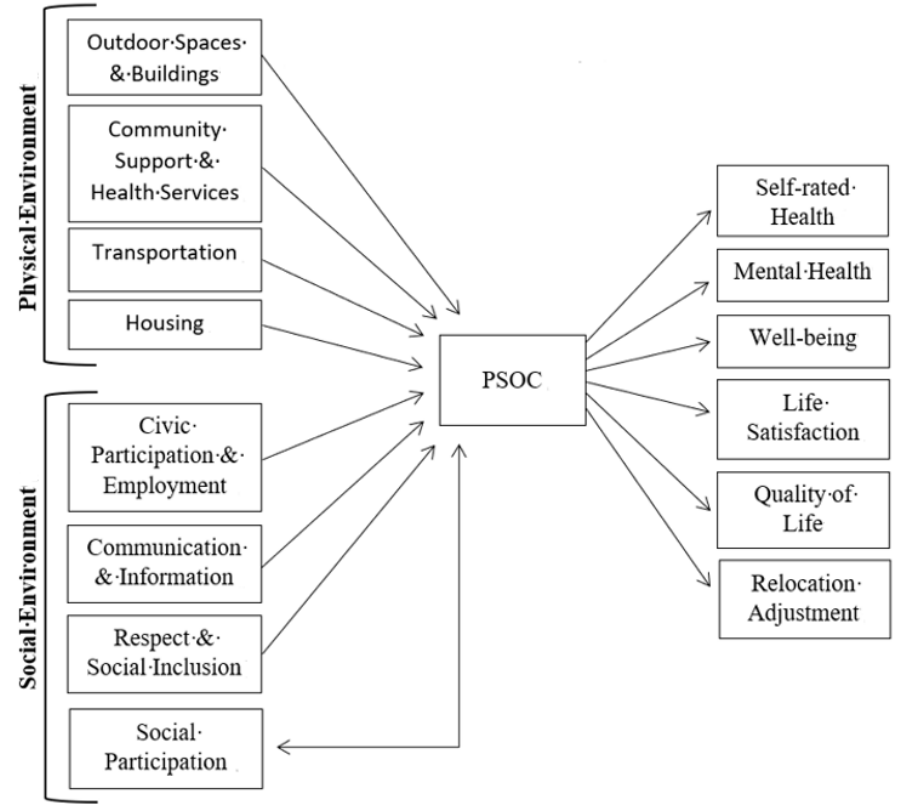
Figure 2. Conceptual Model of Psychological Sense of Community and Related Constructs.